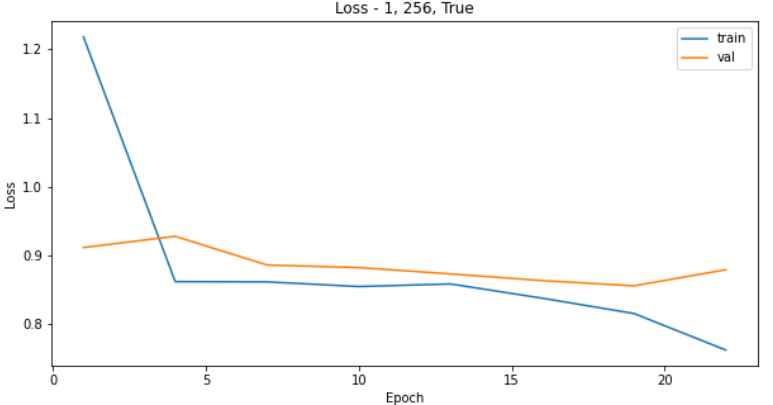
Figure 4. Model loss for the training and validation sets in relation to different number of epochs used to train the